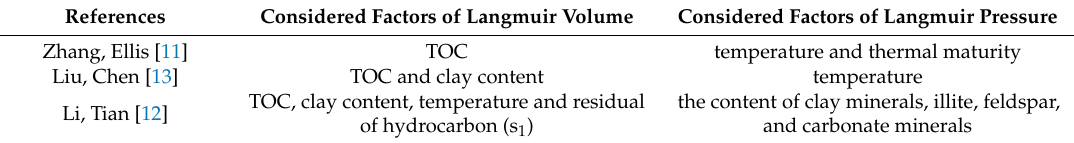
Table 1. Considered factors of the prediction model for Langmuir parameters in previous